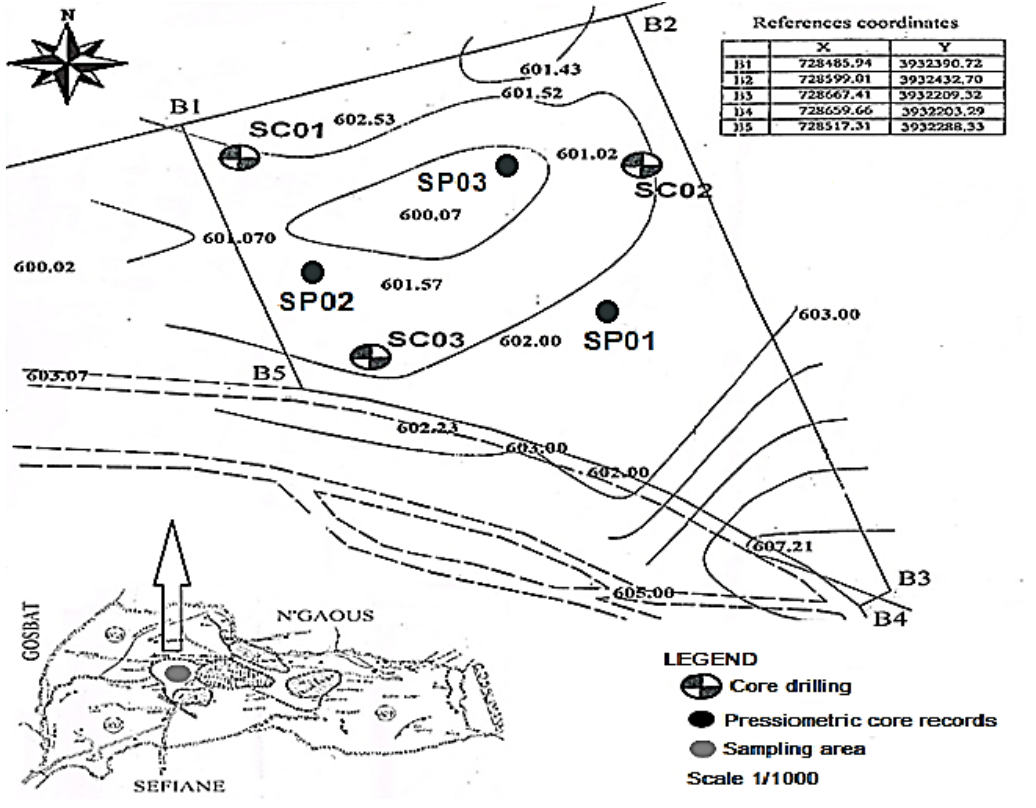
Figure 1: Study area topography and location of core drillings.